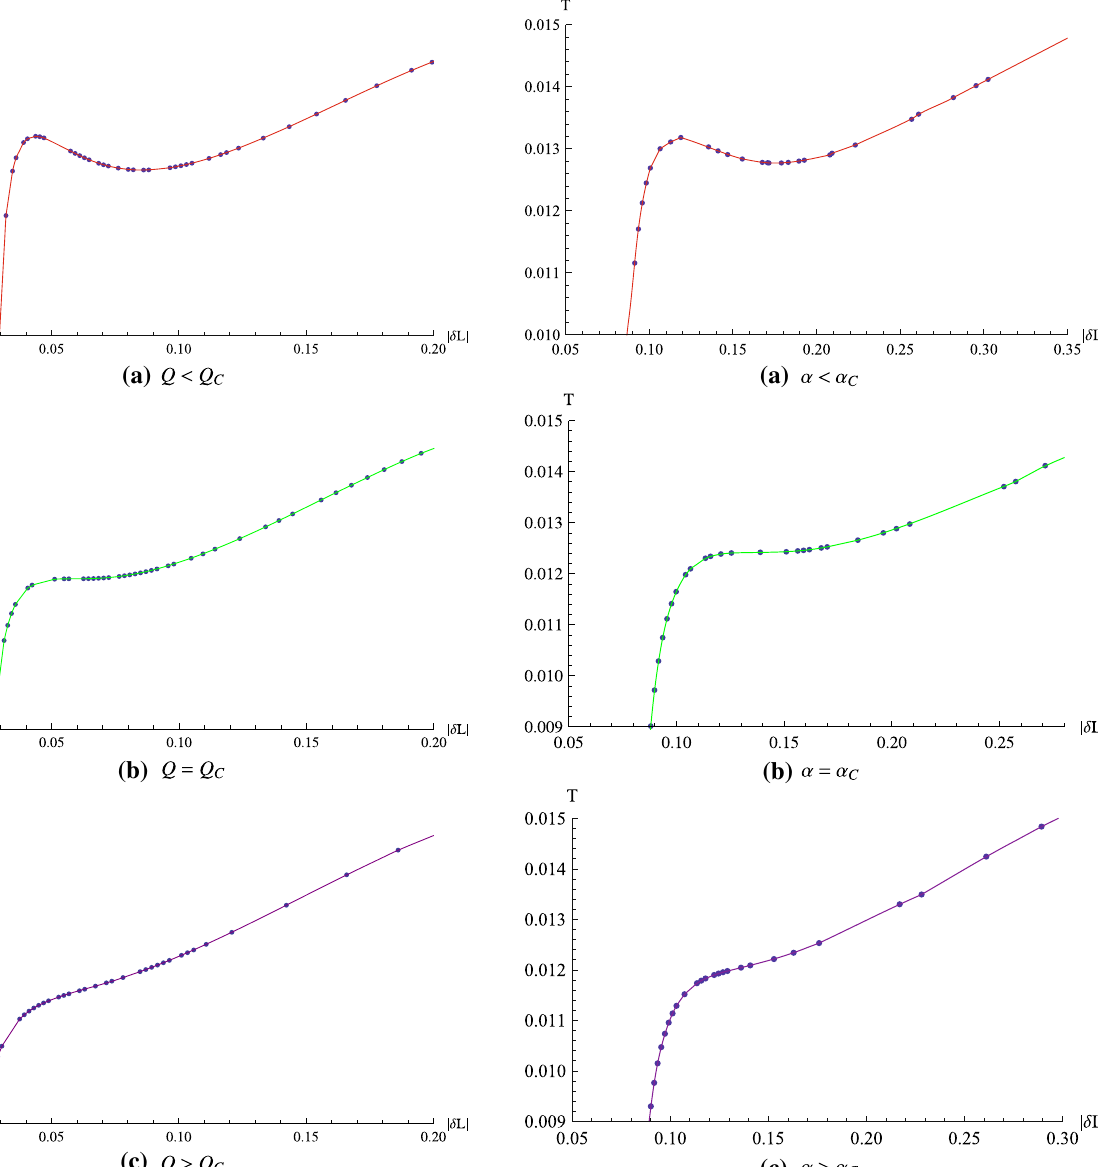
Fig. 7 T −| δ L | diagram for different values Q for the charged Gauss– Bonnet AdS black hole. Here we set parameters α = 1, l = 20, θ 0 = 0 . 35 and θ C = 0 . 349